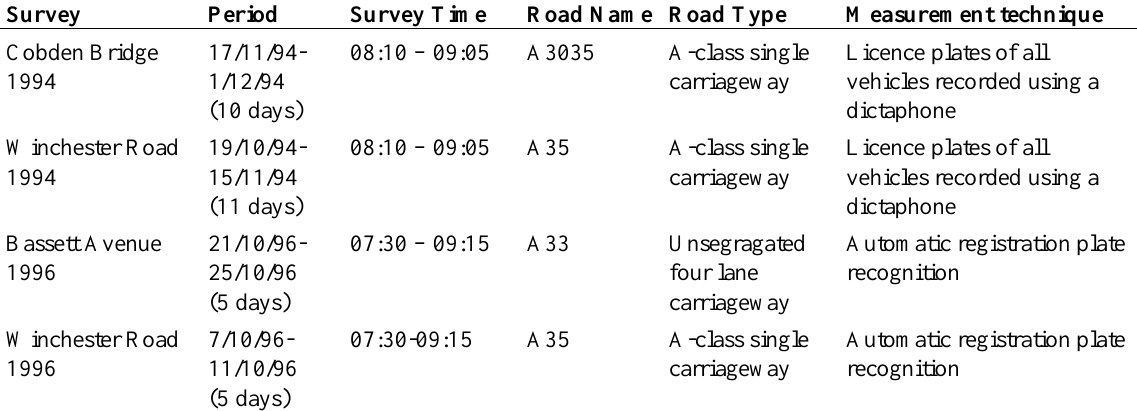
Table 1. Characteristics of the 1994 and 1996 vehicle registration plate surveys in Southampton.